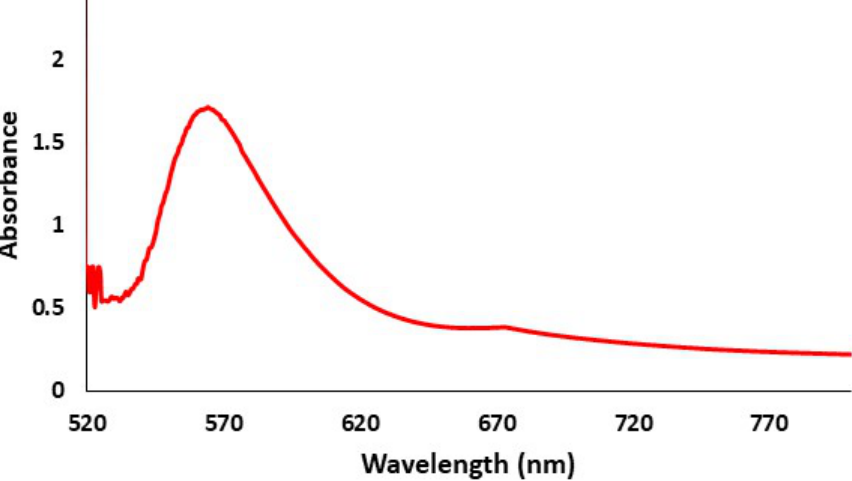
Figure 1. Biosynthesis of TVE-CuNPs using Thymus vulgaris extract.